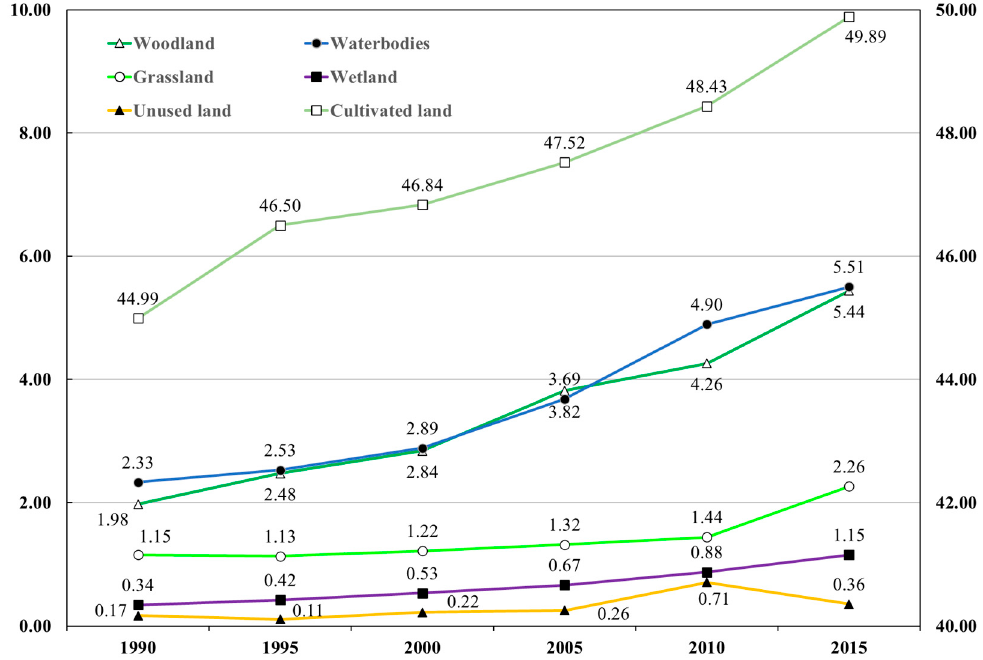
Figure 5. The percent of the grid numbers of vulnerable landscape in the total grid numbers of the YRD from 1990 to 2015 ( V i ≥ 0.6 for all kinds of natural landscapes). Cultivated land was on a secondary y-axis because of the scale differences compared with other natural